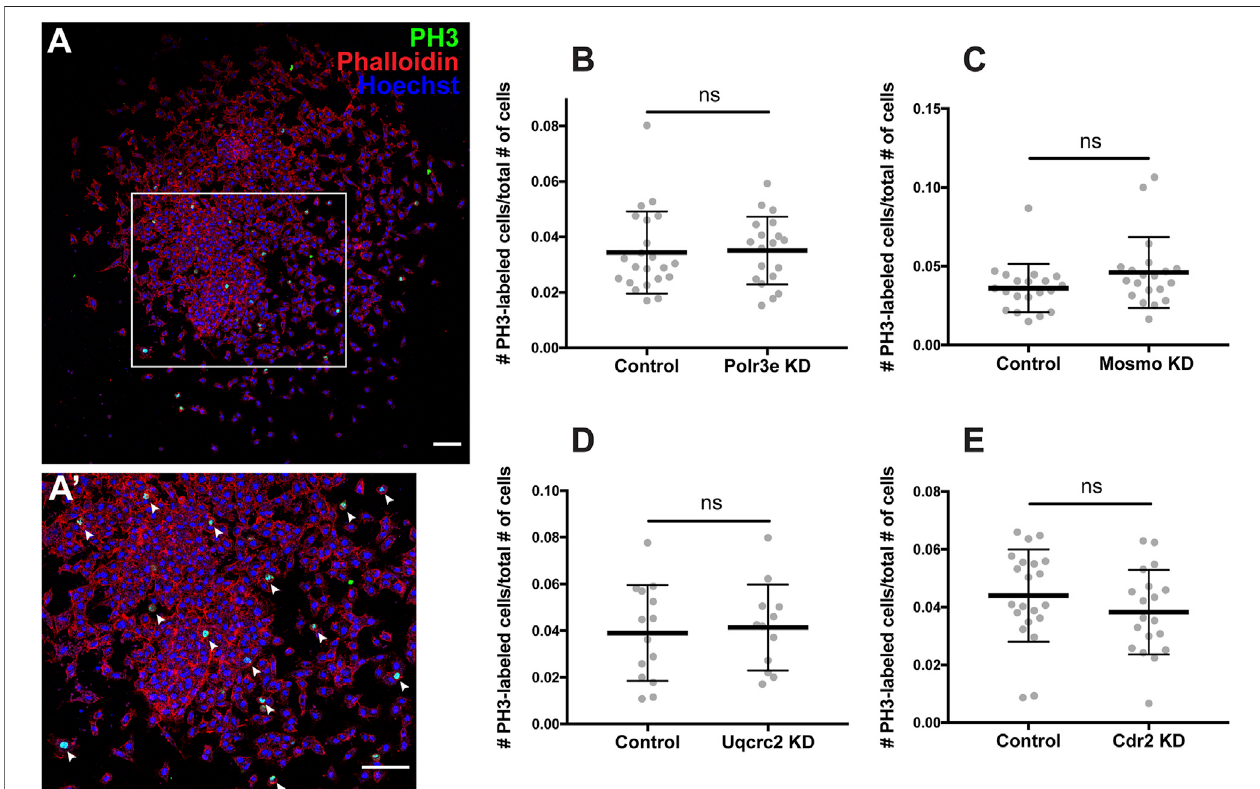
FIGURE 5 | Manipulation of 16p12.1-affected genes does not impact NCC proliferation in vitro . Dissected NCC explants from control, Polr3e KD, Mosmo KD, Uqcrc2 KD, and Cdr2 KD embryos were plated on fi bronectin-coated coverslips, allowed to adhere and begin migration for 4 h before being fi xed in 4% PFA and immunostained with PH3 antibody as a marker for NCC proliferation, phalloidin to label the actin cytoskeleton, and Hoechst to label nuclei. (A,A 9 ) Representative image ofcontrolNCCexplantimmunostainedwithPH3,phalloidin,andHoechst.WhitearrowsdenotecellspositivelylabeledforPH3. (B – E) Quanti fi cationofthenumber of positively PH3-labeled cells versus the total number of cells per NCC explant for Polr3e KD, Mosmo KD, Uqcrc2 KD, and Cdr2 KD compared to controls. Partial depletion of each individual 16p12.1-affected did not have a signi fi cant impact on NCC proliferation in vitro . (Explants quanti fi ed: 6-7 explants from control and KD embryos were plated for each experiment. Three separate experiments were performed for each depletion). **** p < 0.0001, *** p < 0.001, ** p < 0.01, * p < 0.05, n.s., not signi fi cant. Scalebar = 300 μ m.